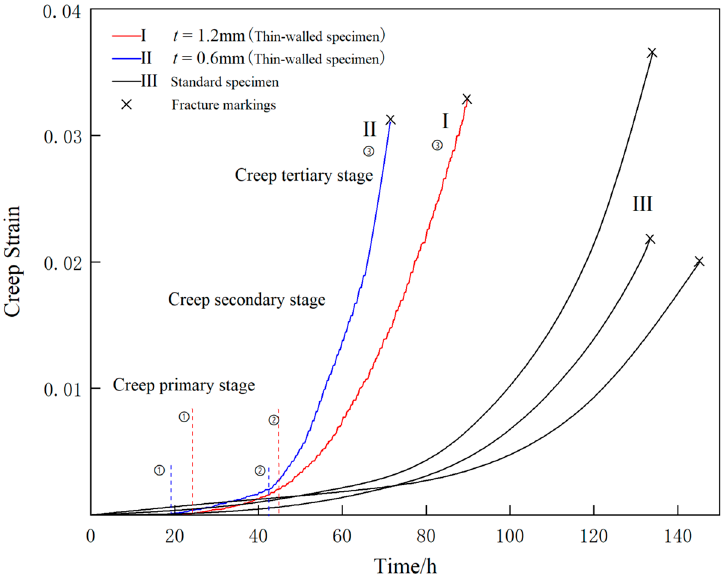
Figure 9. The average creep strain vs. time curves of the thin-walled specimens and standard specimens at 980 °C/250 MPa.